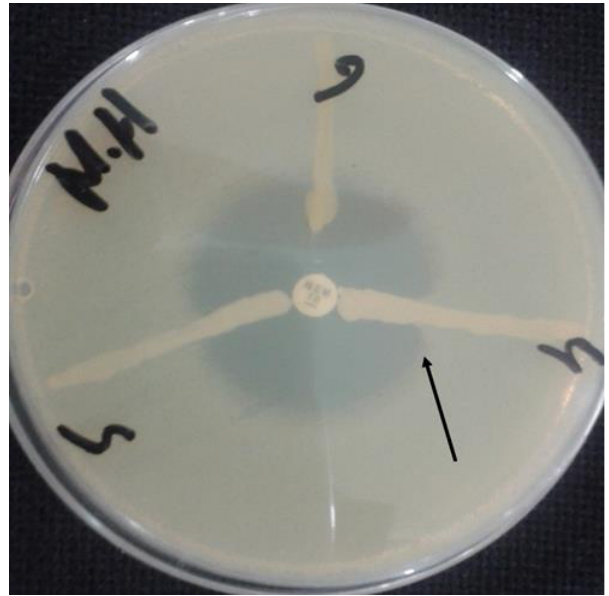
Figure 3. Phenotypic carbapenemase confirmation by the modified Hodge test. Table 2. Dissemination of CRACB from clinical sources and hospital